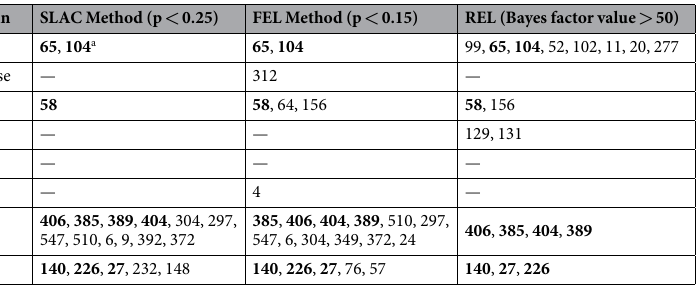
Table 1. Positive selection analyses of different viral proteins based on SLAC, FEL, and REL. a Positions in bold font style indicate the positive selection sites verified by three